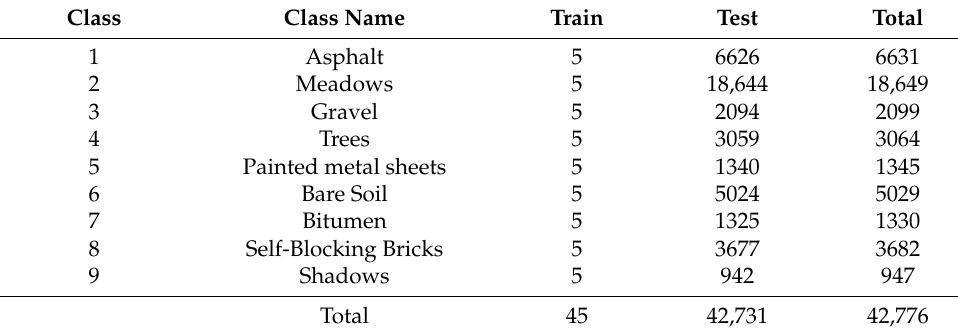
Table 2. The Numbers of Training, Testing, and Total Samples in UP